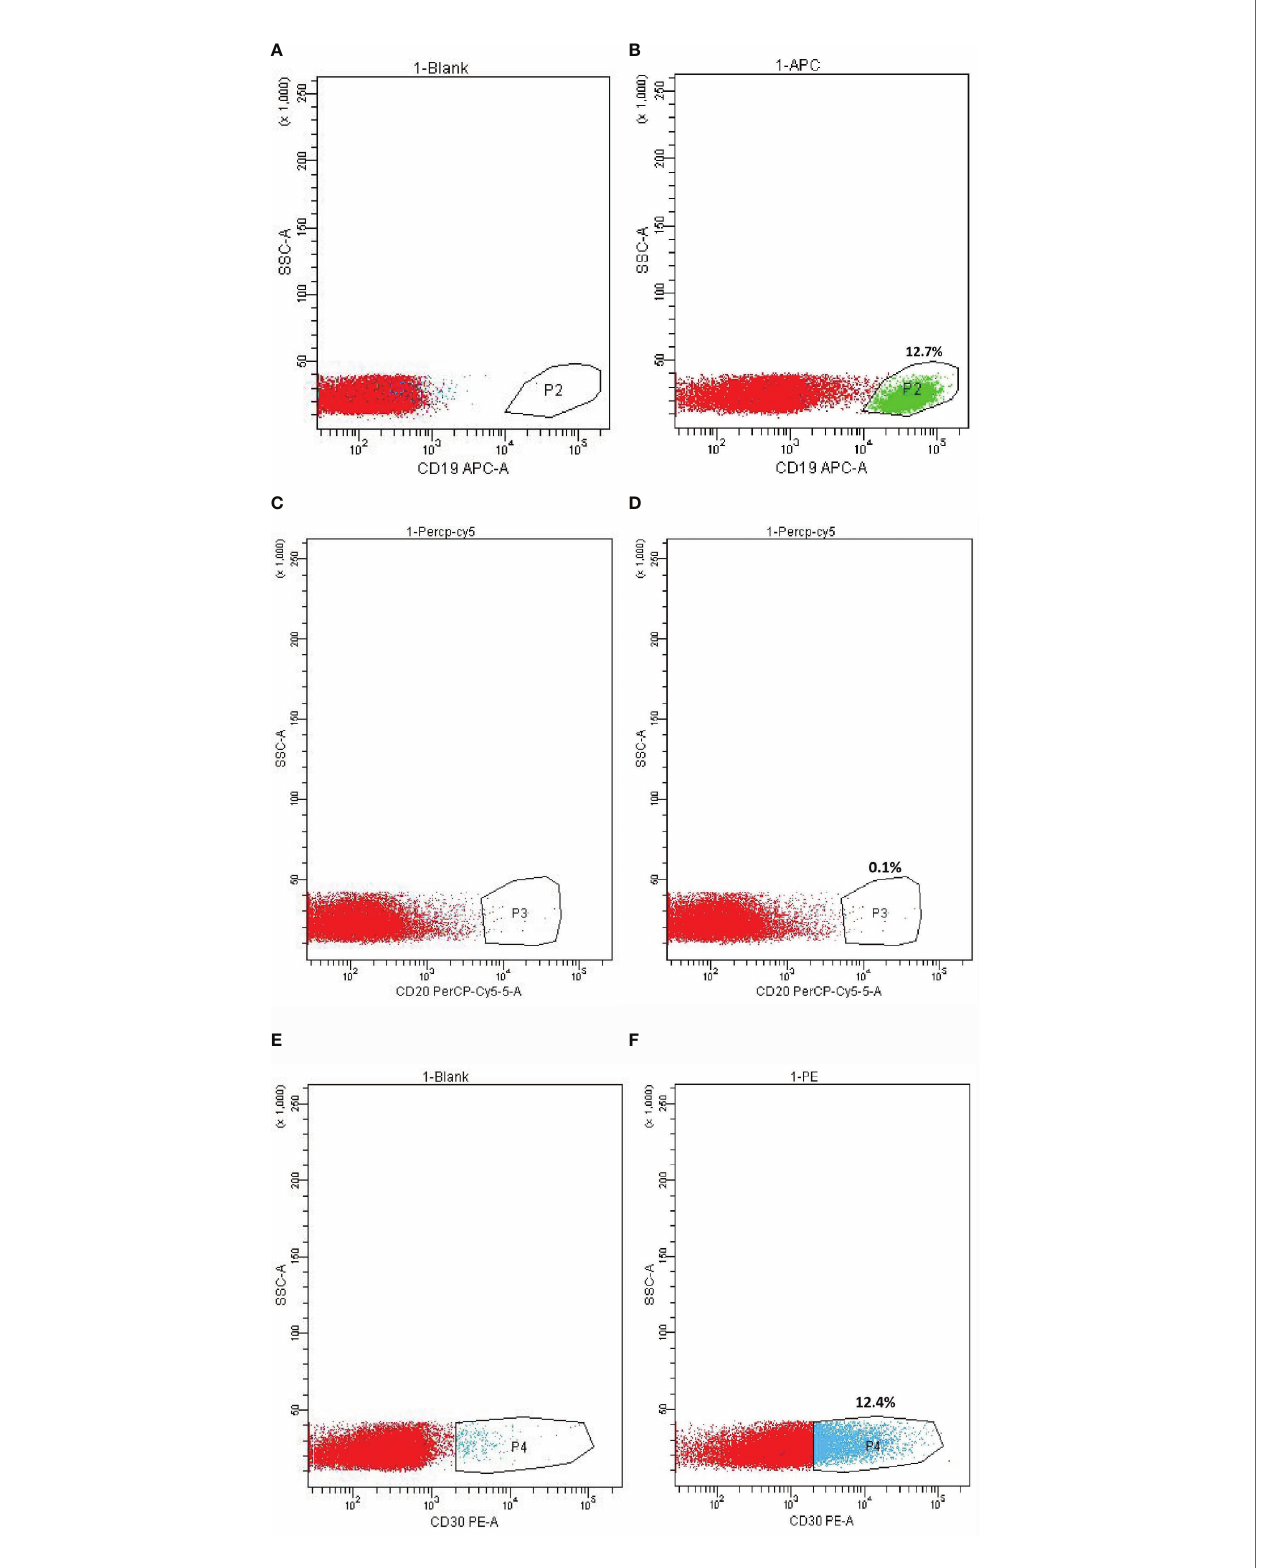
FIGURE 2 | Flow Cytometry (FCM) on CD19, CD20, and CD30 expression in metastatic lymphoma tissue. (A) CD19 expression cell control. (B) CD19-positive cells. (C) CD20 expression cell control. (D) CD20-positive cells. (E) CD30 expression cell control. (F) CD30-positive